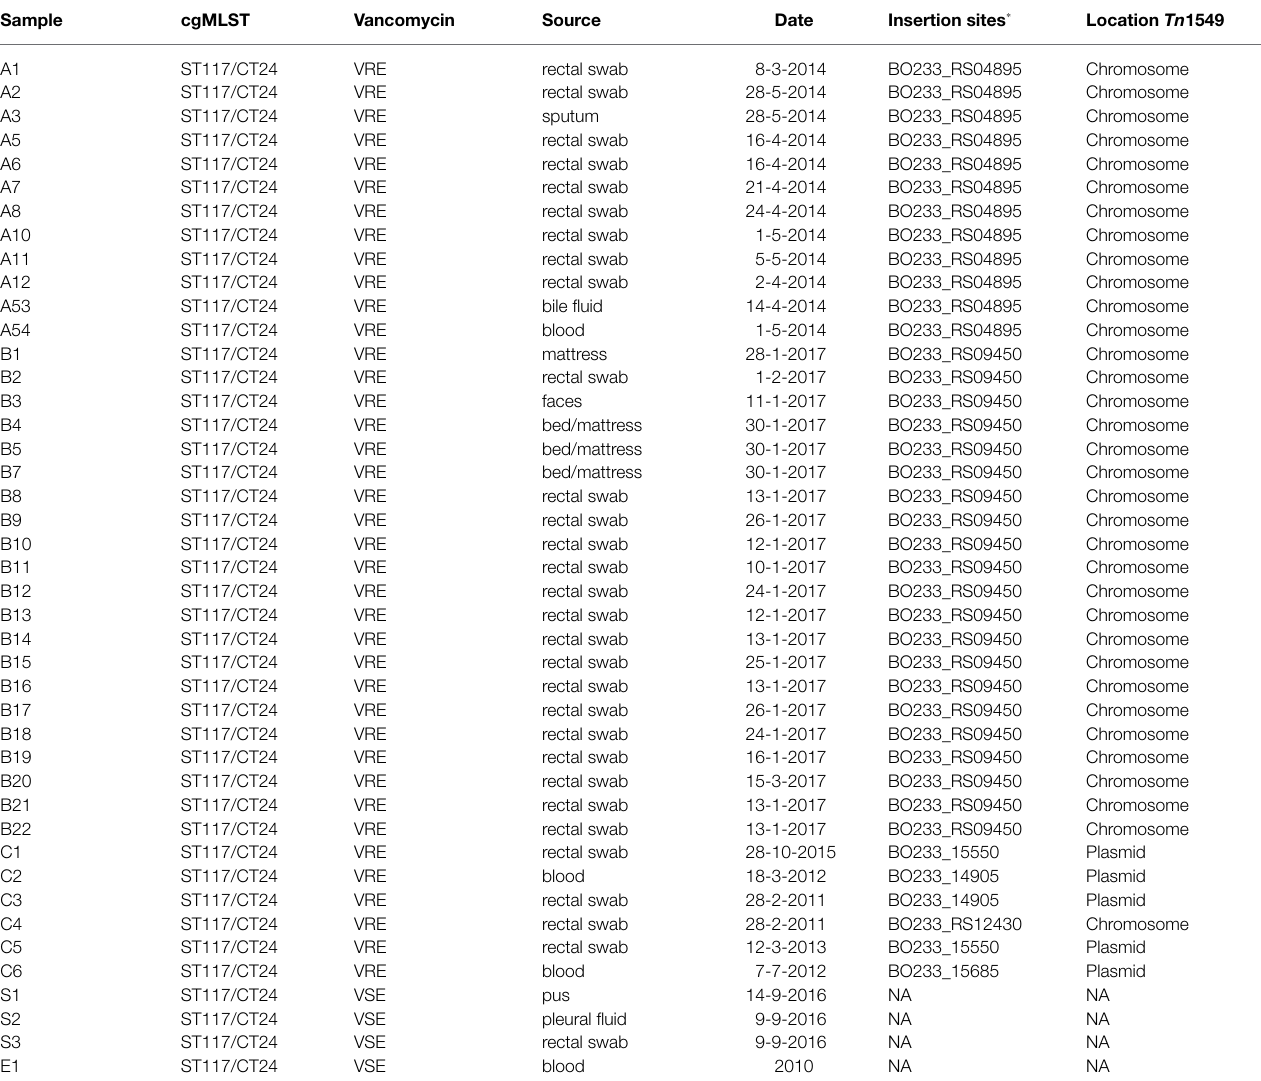
TABLE 1 | Epidemiological and molecular data of the isolates included in this study.